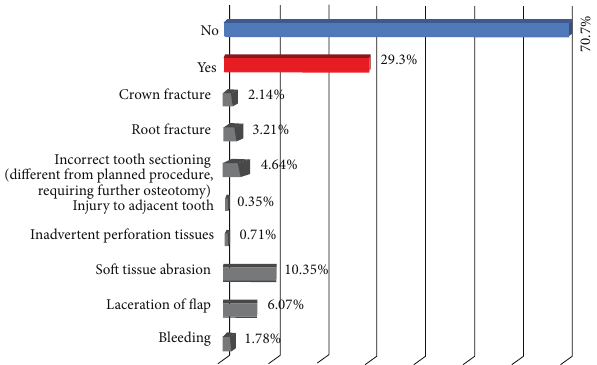
Figure 1: Occurrence of adverse events during the removal of impacted lower third molars in overweight patients.